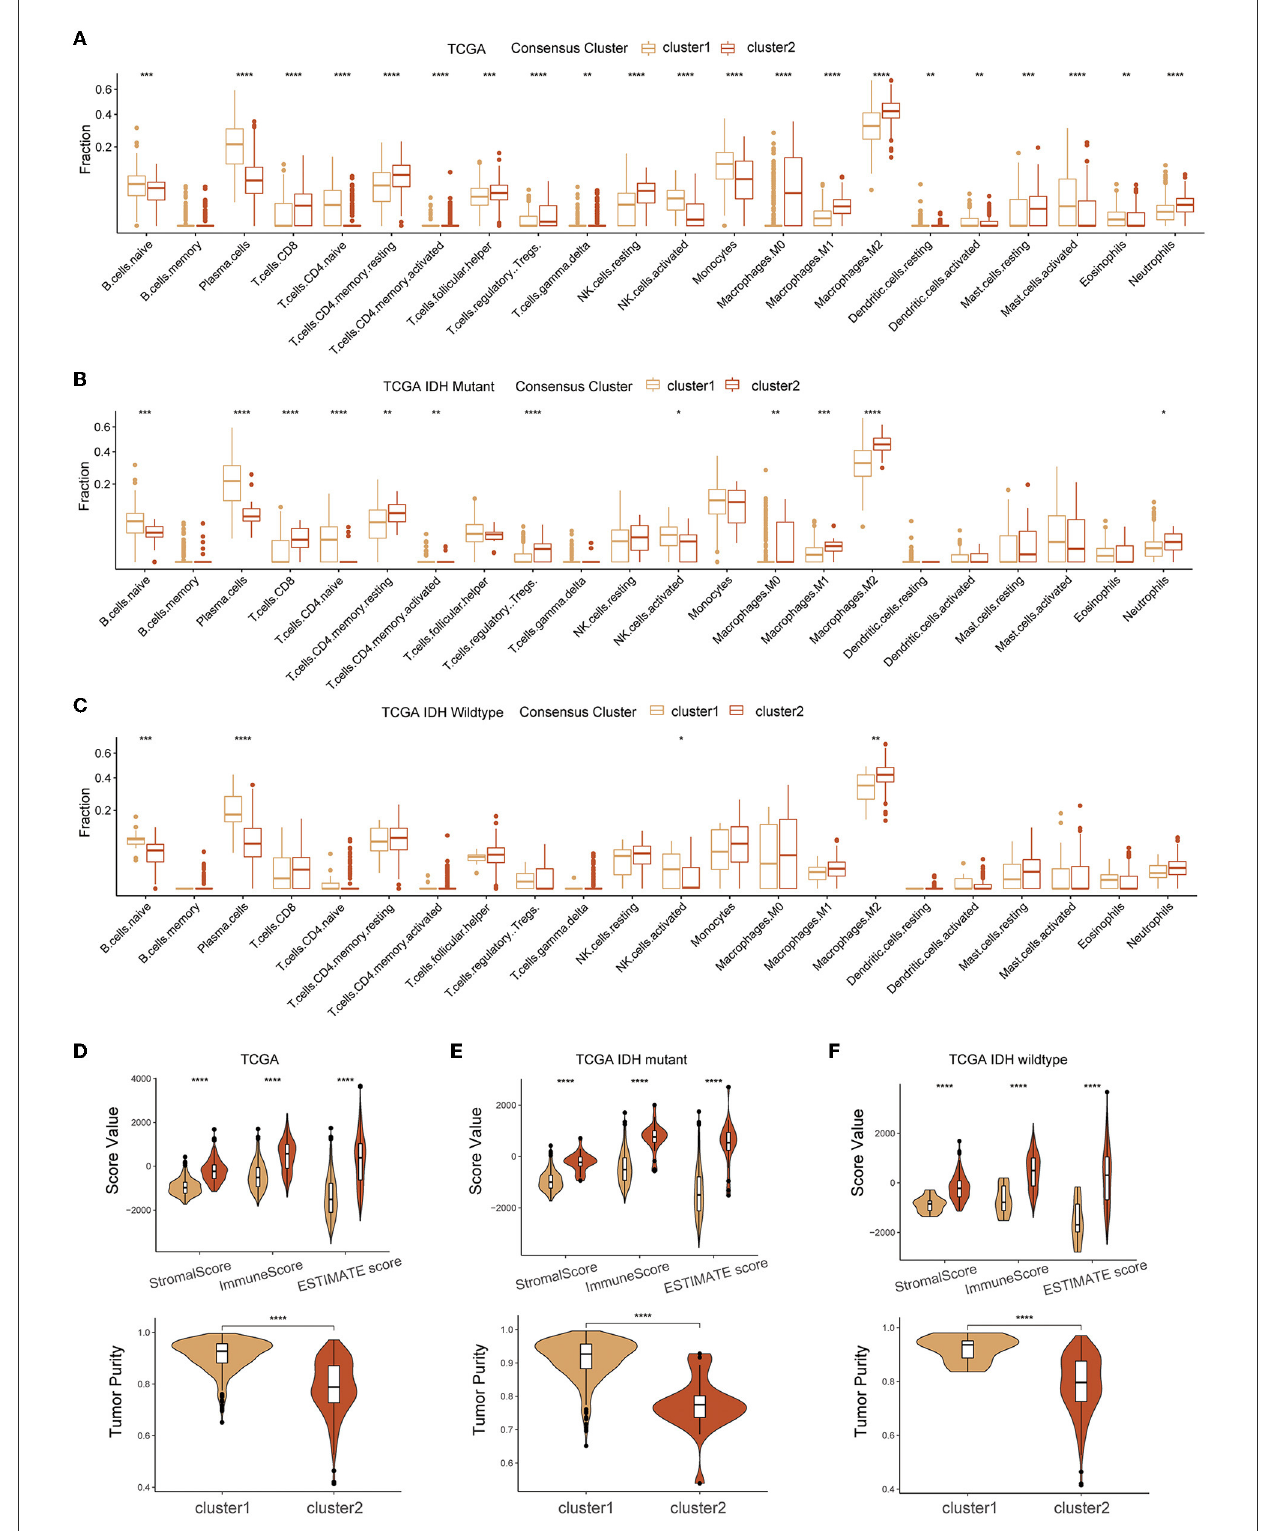
FIGURE4 Association between TME infiltration of diffuse glioma and GMRG expression clusters. CIBERSORTx (A–C) and ESTIMATE (D–F) algorithm for evaluating TME immune characteristics of diffuse glioma in the entire TCGA cohort and subgroups based on IDH mutation status. TME, tumor microenvironment; GMRG, glutamine metabolism-related genes; ESTIMATE, estimation of stromal and immune cells in malignant tumor tissues using expression data; TCGA, The Cancer Genome Atlas; IDH, isocitrate